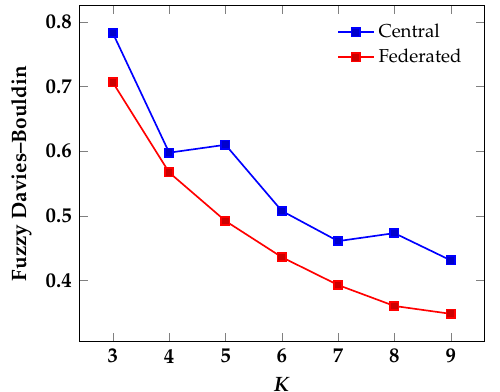
Figure 6. Federated fuzzy Davies–Bouldin index for different number of